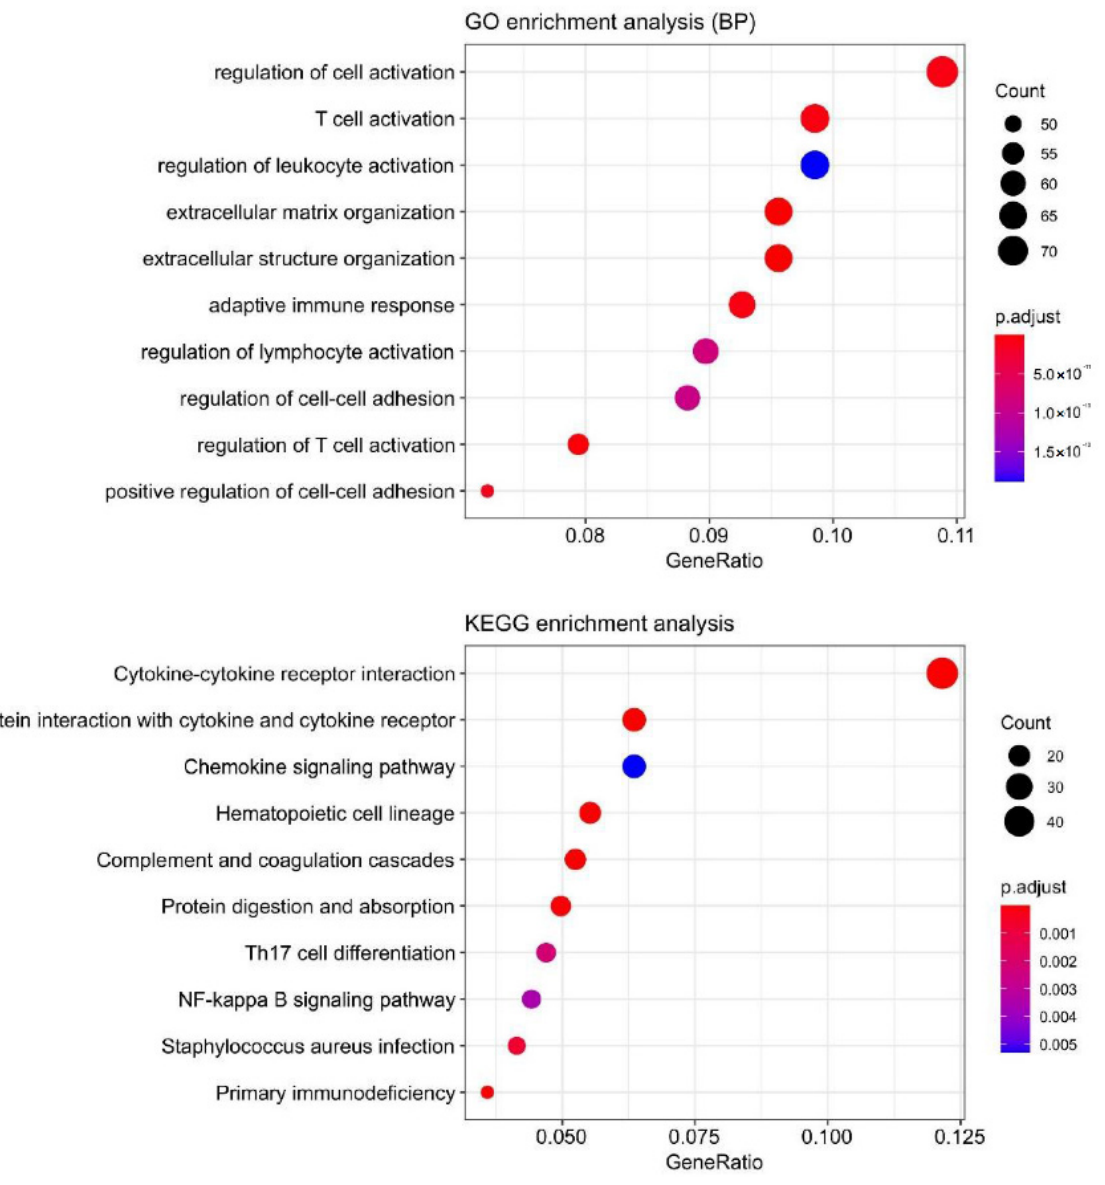
Figure 5. Functional and pathway enrichment analyses of DEGs between low and high SEMA7A KIRC subgroups (cut-off: 50%). ( A ) GO enrichment analysis in cellular components (CC), molecular functions (MF) and biological processes (BP). ( B ) KEGG enrichment analysis of DEGs.